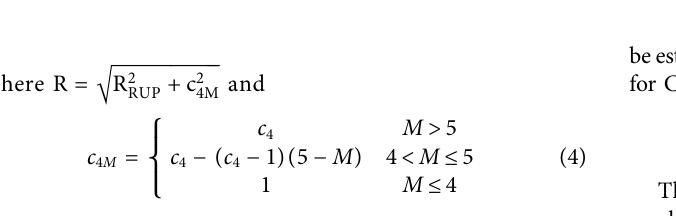
FIGURE 5 | The logarithm of predicted PGA (PGA GMPE ) minus the logarithm of observed PGA (PGA OBS ) as functions of (A) catalog moment magnitude and (B) source-to-sitedistance.DiscrepanciescalculatedusingCH09,ASK14andLZ18areindicatedbybluecircle,blacklineandreddots,respectively.Averagediscrepancies (µ) and standard deviations to the residuals ( σ ) between predicted and observed PGAs are indicated in the legend.